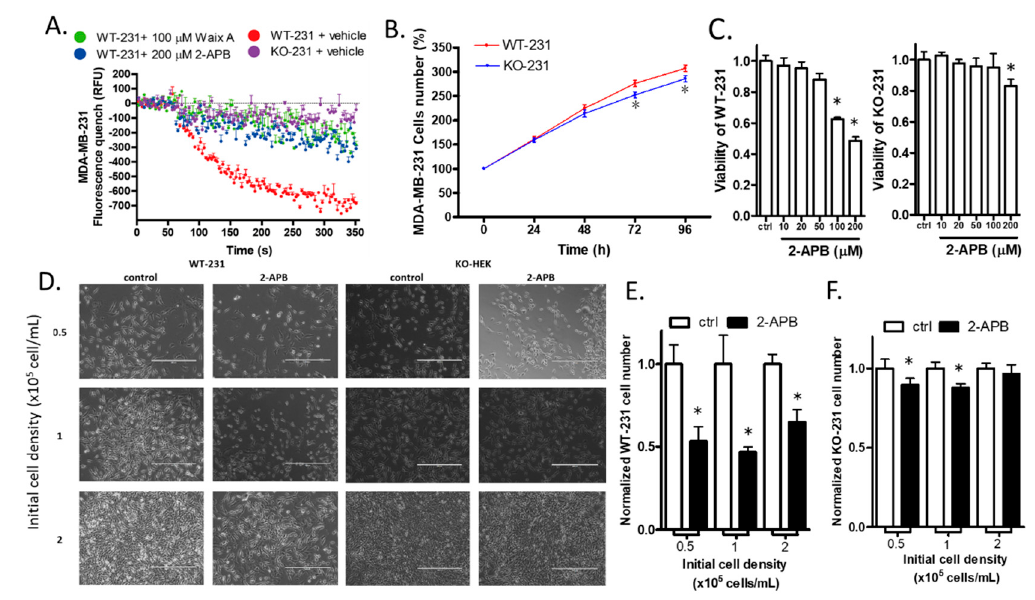
Figure 6. The effect of TRPM7 knockout on MDA-MB-231. ( A ) Mn 2+ flux. Mn 2+ and drugs were added after the 50 s baseline measurement. Fura-2AM-based fluorescence quench assay showed that knock-out of TRPM7 in MDA-MB-231 (KO-231) suppressed the function of TRPM7 channels. The block by 2-APB or Waix A in wild type MDA-MB-231 (WT-231) was used as positive controls. ( B ) Cell proliferation. Knock-out of TRPM7 in MBA-MD-231 did not significantly affect cell number within 48 h but decreased cell number after 72 and 96 h. ( C ) Viability. 2-APB (100 µM, which was used in the subsequent experiments) suppressed viability in WT-231 only, while 2-APB (200 µM) significantly suppressed viability in both WT-231 and KO-231, with a higher suppression rate in WT-231 than KO-231. ( D ) Cell number. Representative images from the cell counting experiment of MDA-MB-231 cells. Cells were planted in different cell densities and were treated with 200 µM 2-APB for 24 h. The scale bar corresponds to 400 µm. ( E , F ) The cell counting assay showed that 2-APB dramatically decreased the WT-231 cell number in all groups, whereas it only slightly decreased the KO-231 cell number in the 0.5 × 10 5 and 1 × 10 5 groups. Significant differences ( p < 0.05) from the control are indicated by “*”.